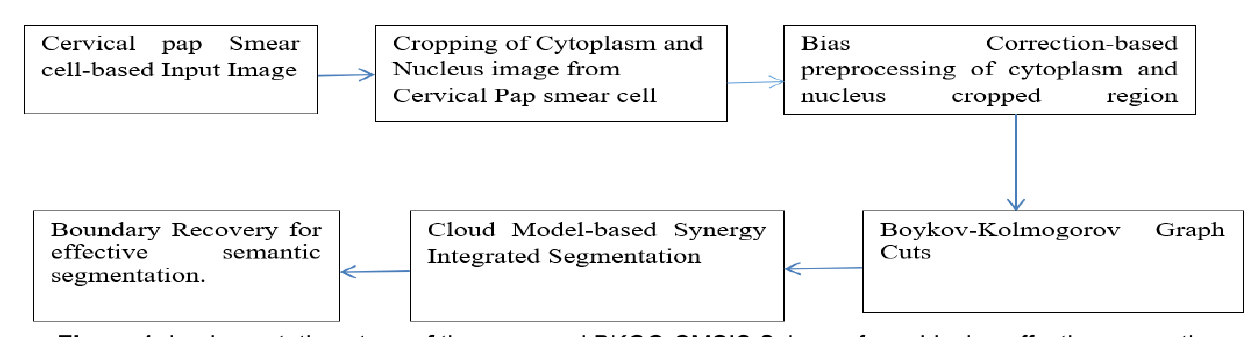
Figure 1. Implementation steps of the proposed BKGC-CMSIS Scheme for achieving effective semantic segmentation in cervical cancer